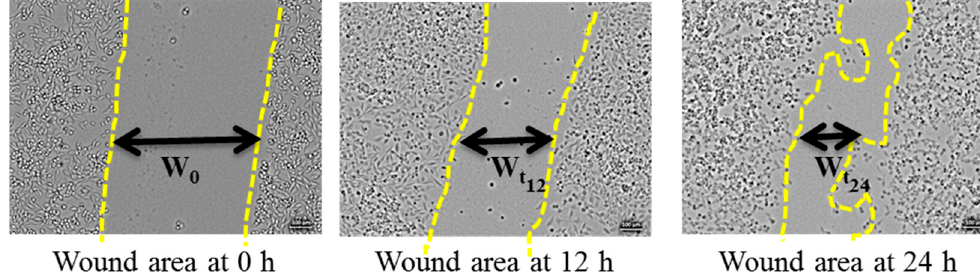
Figure 1. Representative images of scratch wound healing assay at 0, 12, and 24 h.